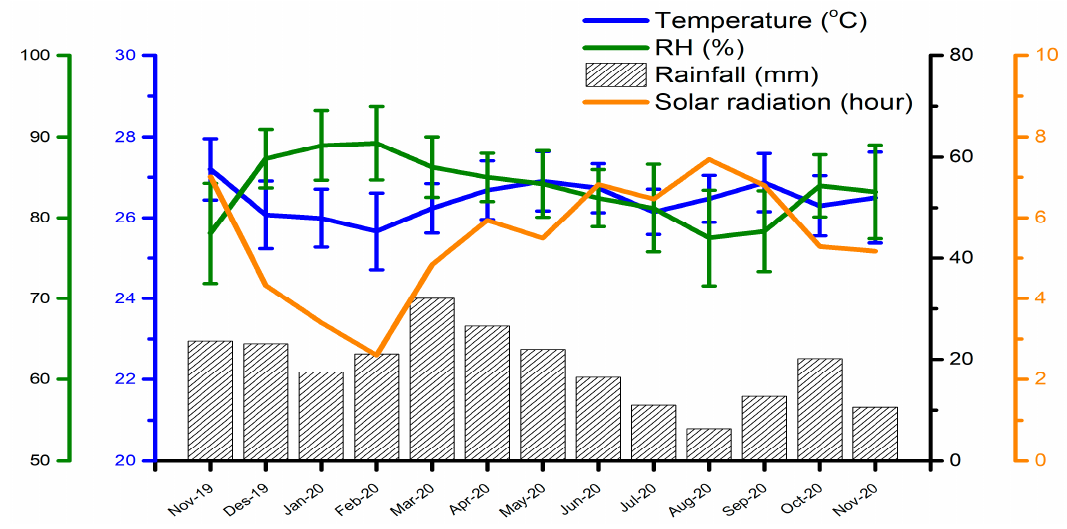
Figure 1. Ombrothermic diagram of the test site.